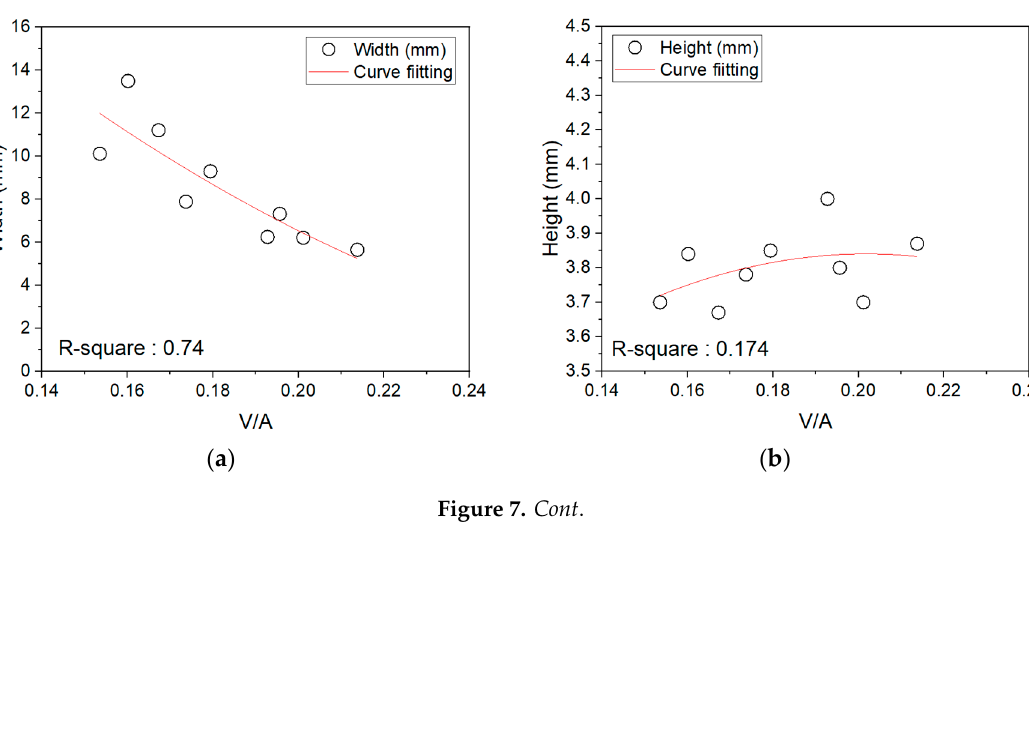
( e ) Figure 7. Geometry fluctuation of beads according to the current and voltage ratio. ( a ) Current and voltage ratio versus width. ( b ) Current and voltage ratio versus height. ( c ) Current and voltage ratio versus contact angle. ( d ) Current and voltage ratio versus bead radius. ( e ) Current and voltage ratio versus circle center position. A bead geometry according to the current and voltage ratio calculated by Equation (2) was observed. Curve fitting was performed to clearly analyze the correlation between the heat input and bead shape, as well as to clearly analyze the correlation between the current and voltage ratio and bead